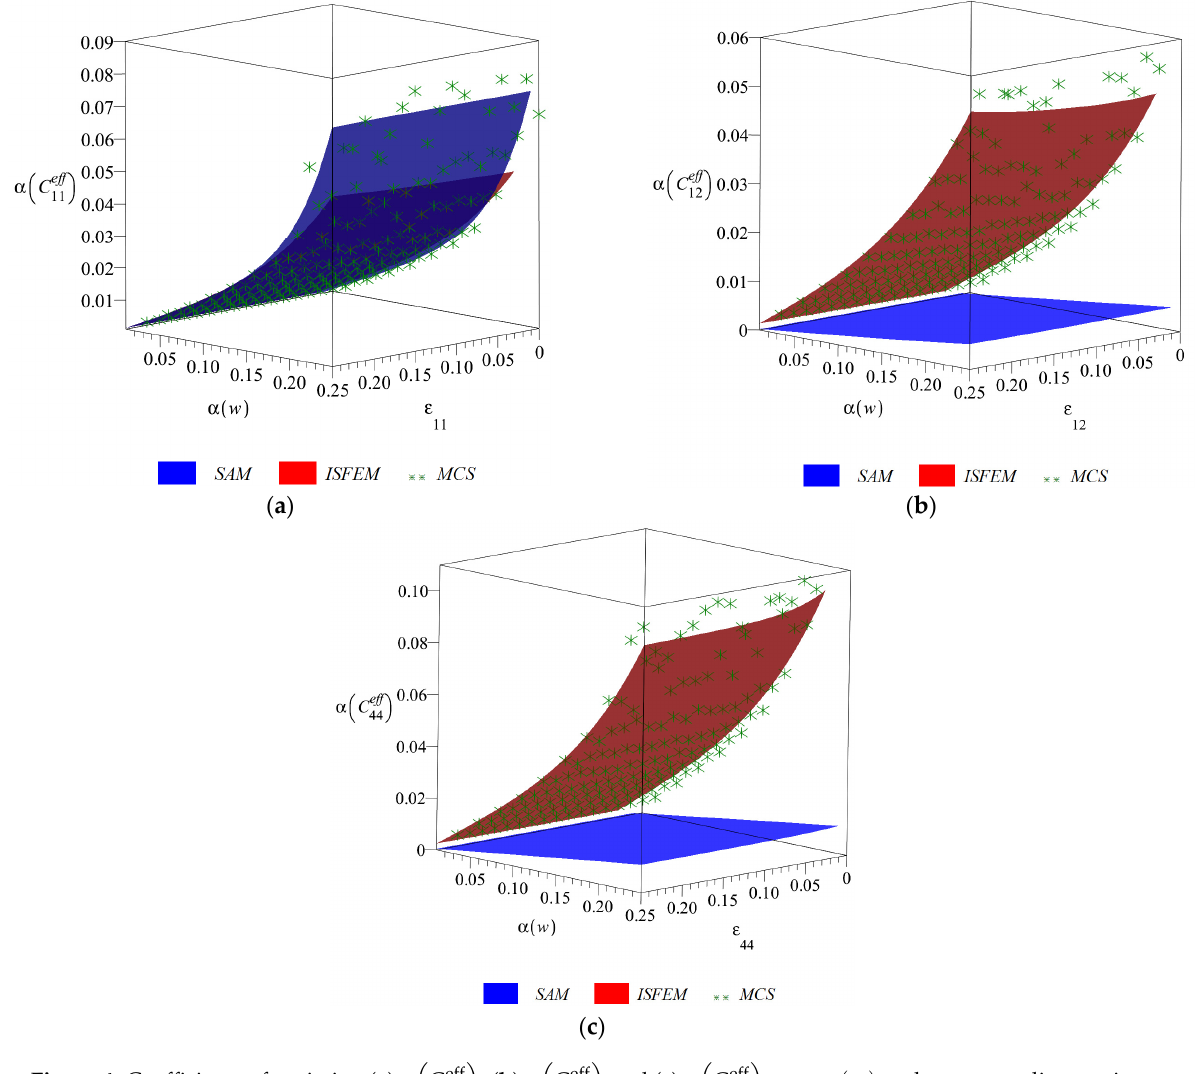
Figure 4. Coefficients of variation ( a ) α (cid:3435) C 11eff (cid:3439) , ( b ) α (cid:3435) C 12eff (cid:3439) and ( c ) α (cid:3435) C 44eff (cid:3439) w.r.t. α (cid:4666) w ) and corresponding strain ε ij .